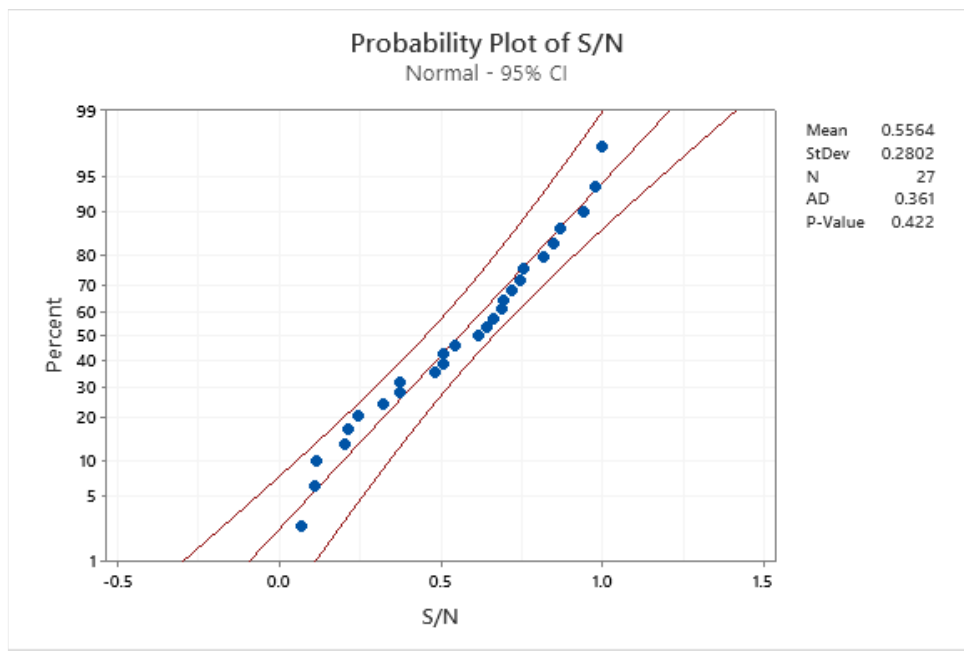
Figure 8. Probability plot of S/N, data points (blue dots) are relatively close to fitted normal distribution lines